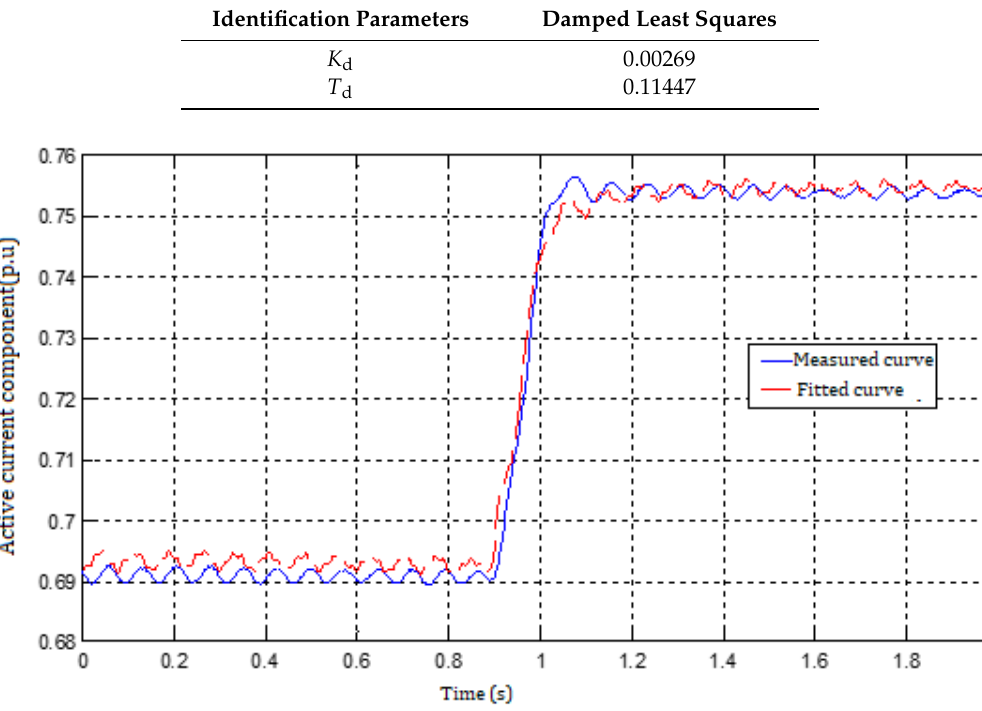
Figure 12. Active current fitted curve under small disturbance of grid voltage.